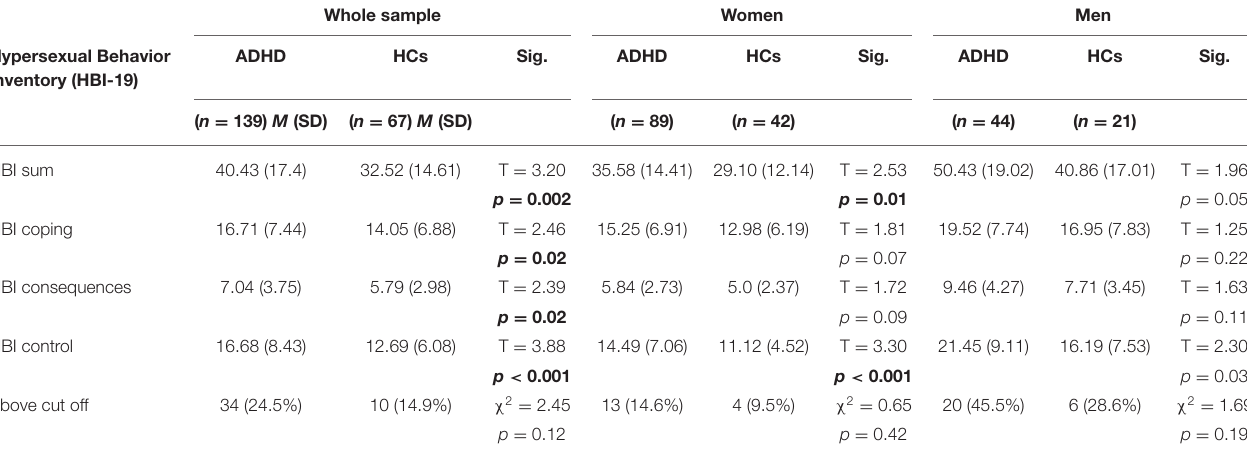
HCs, healthy controls. Bold values mean statistical significance after correcting for multiple